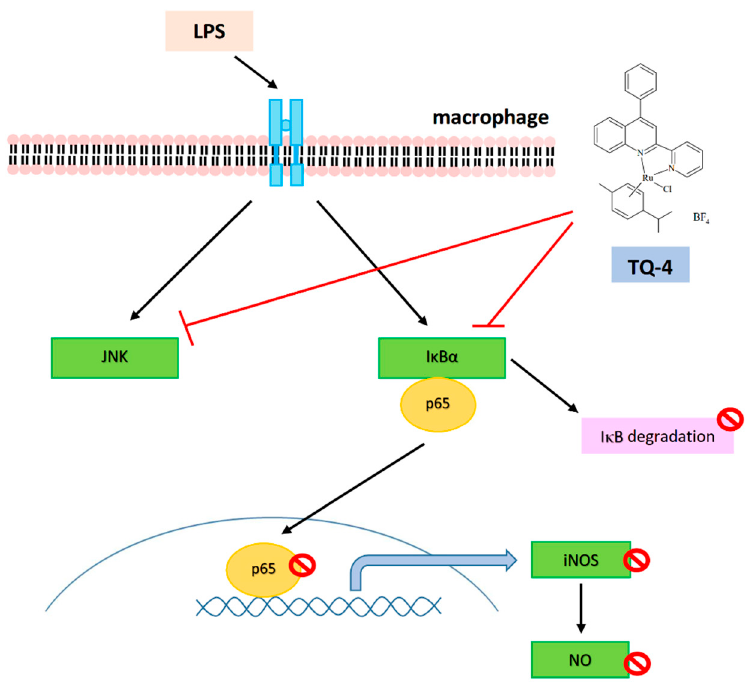
Figure 2. In vitro anti-inflammatory mechanism of TQ-4 compound: TQ-4 inhibits NO production and iNOS expression, JNK phosphorylation, I κ B α degradation, NF- κ Bp65 phosphorylation and its nuclear translocation in LPS-induced RAW 264.7 cells.